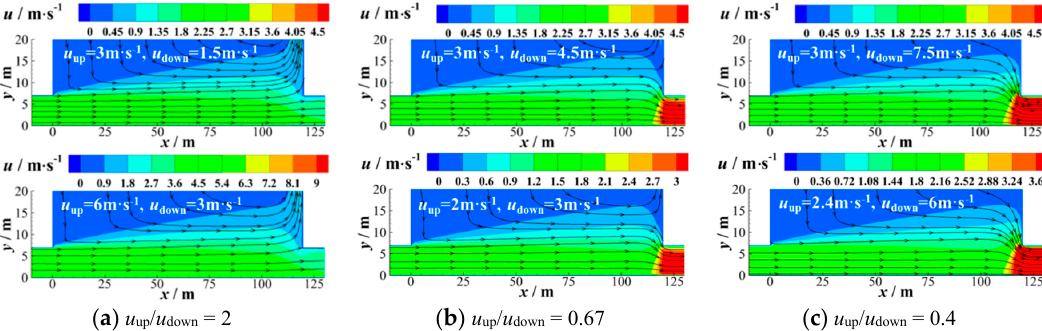
Figure 5. Series-flow structure for different values of u up / u down.